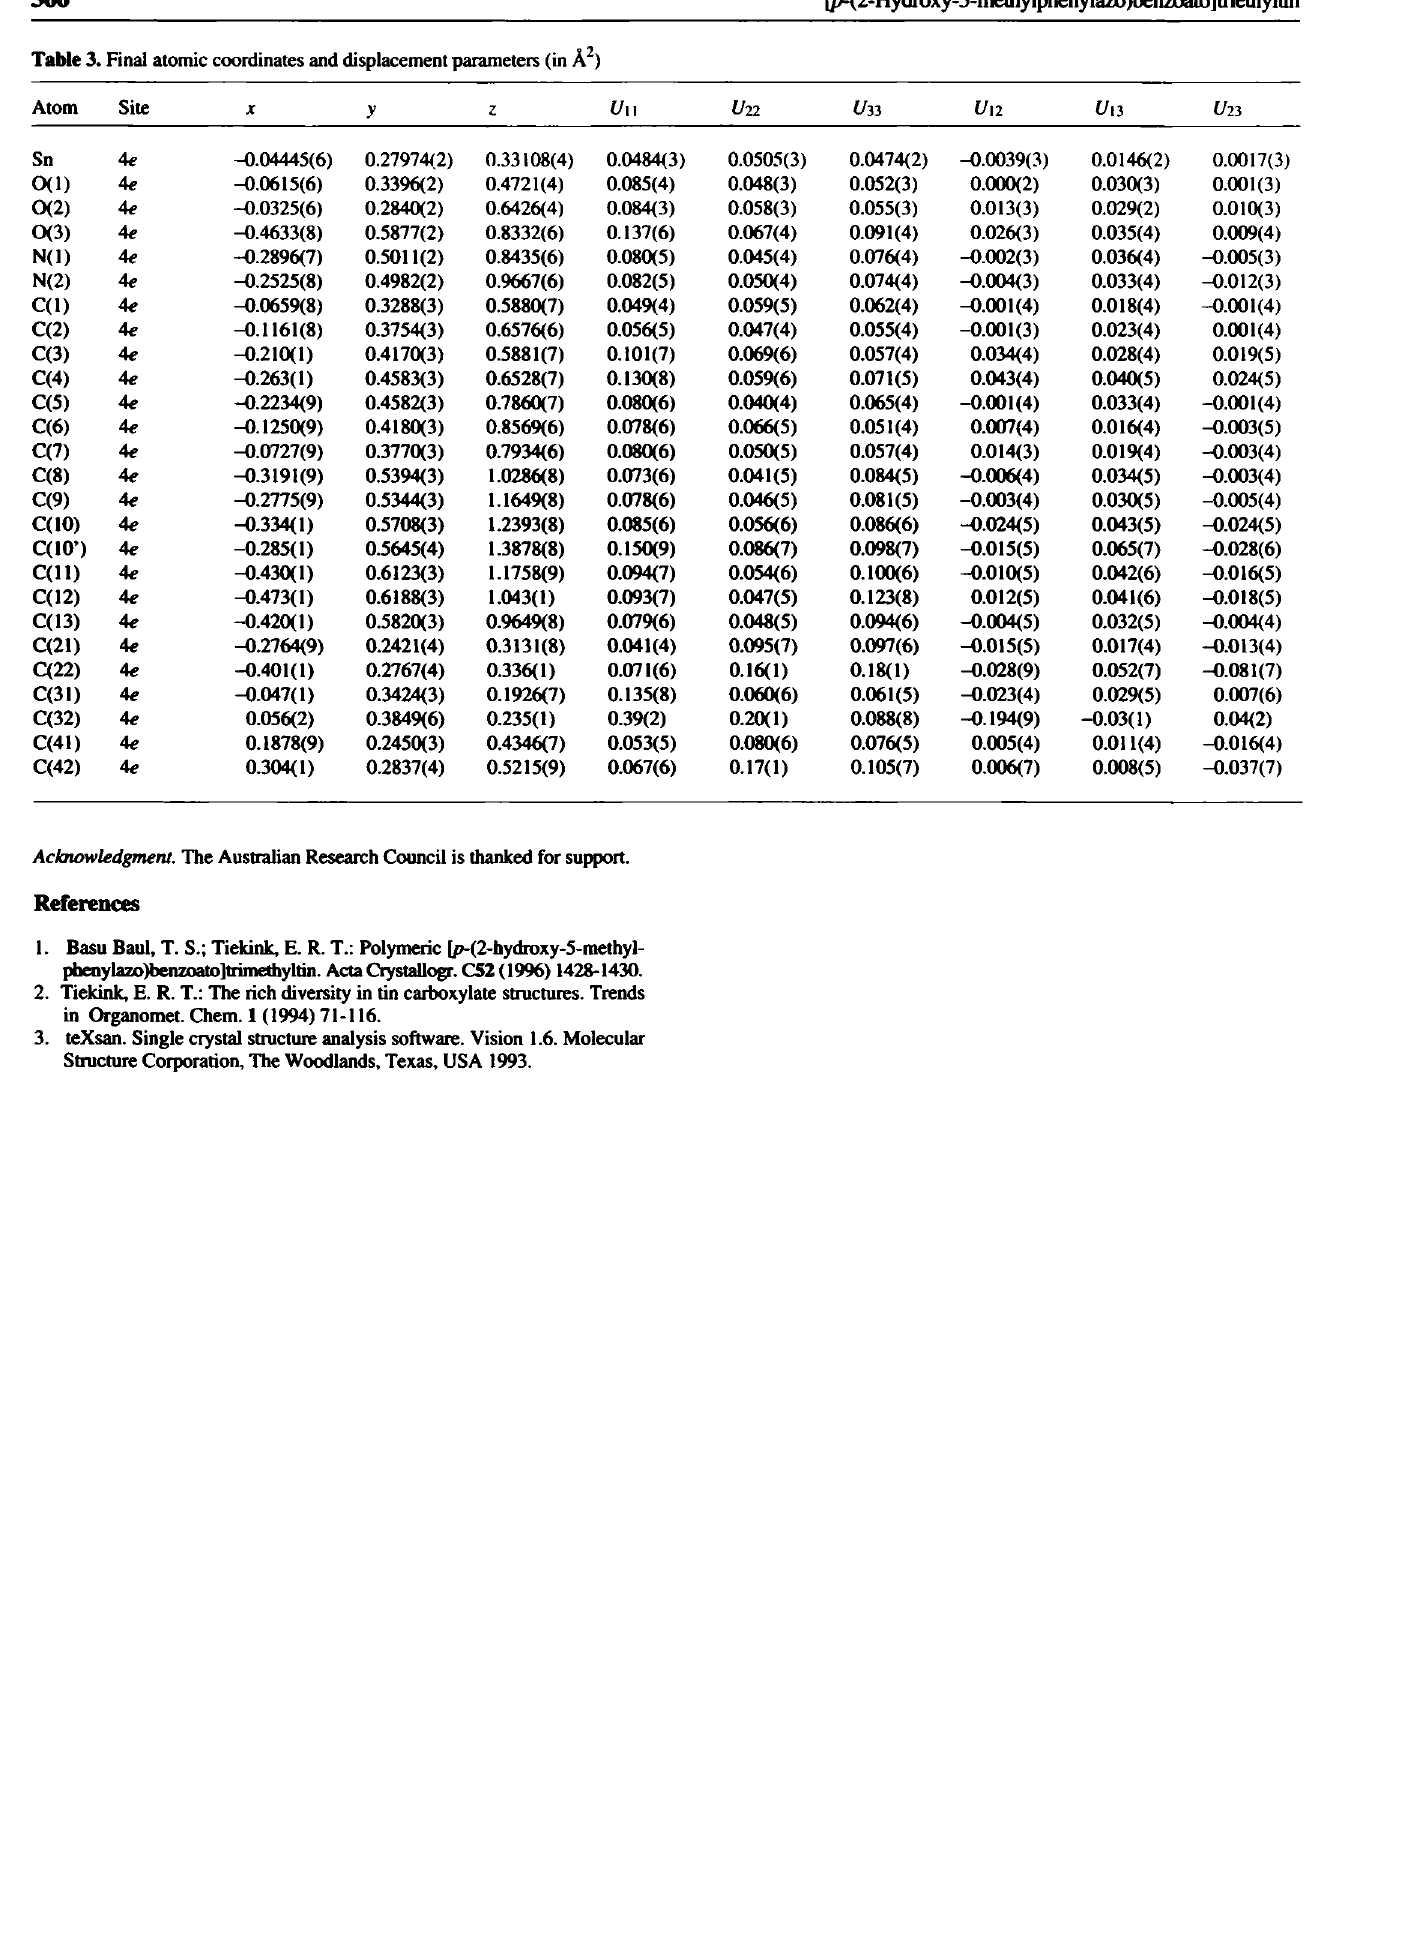
Table 3. Final atomic coordinates and displacement parameters (in À 2